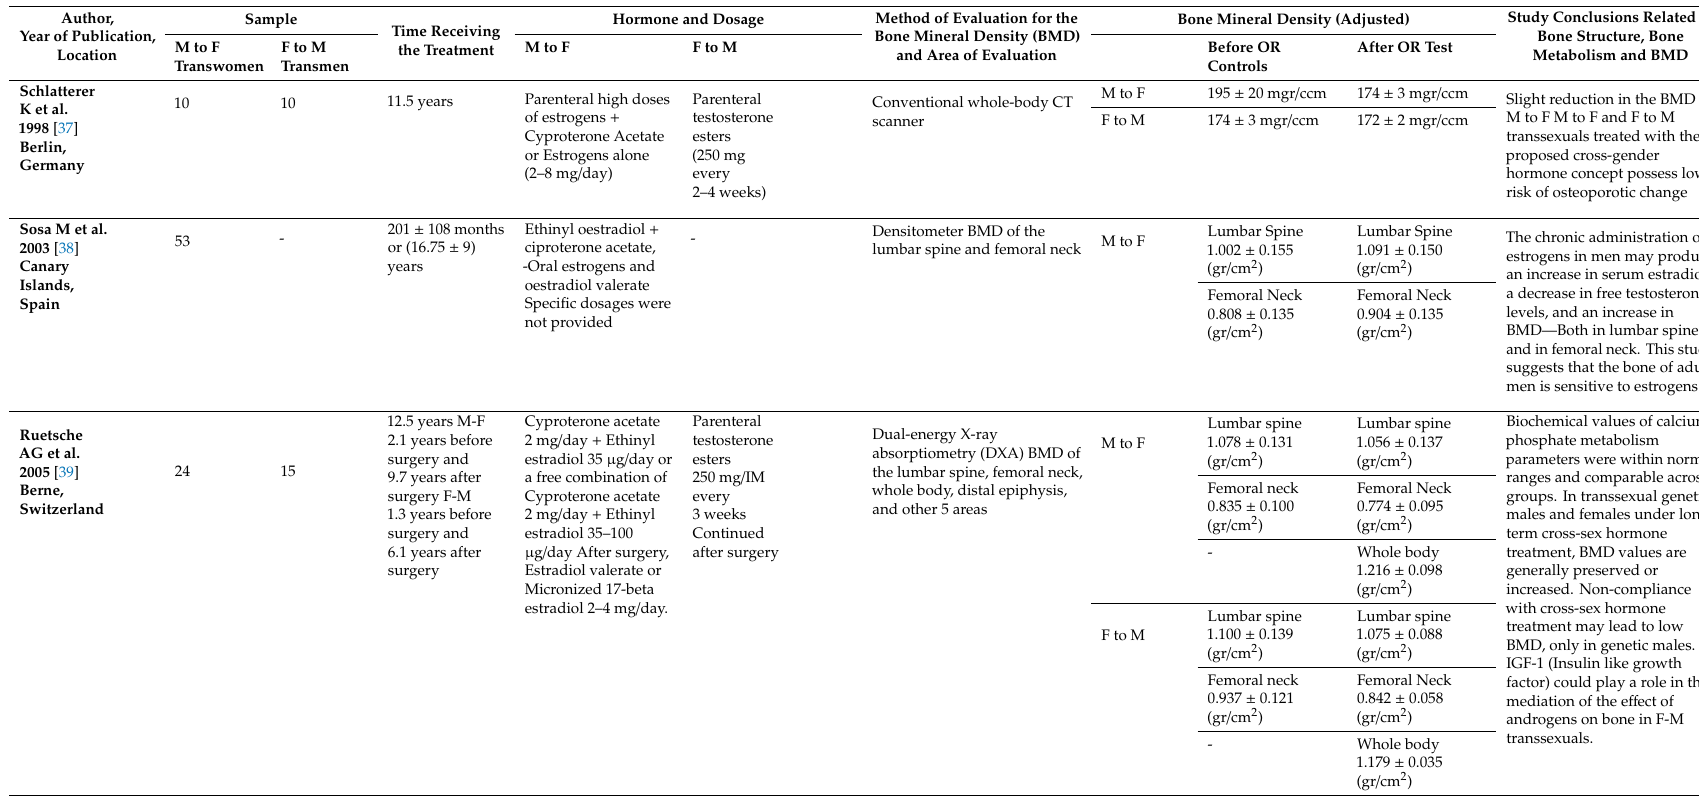
Table 1. Demographics, time receiving treatment, and medication received. Bone mineral density (BMD) and method of evaluation and study conclusions related to bone structure, bone metabolism, and bone mineral density. Variability was observed in drug dosages and regions for BMD. M, male; F,